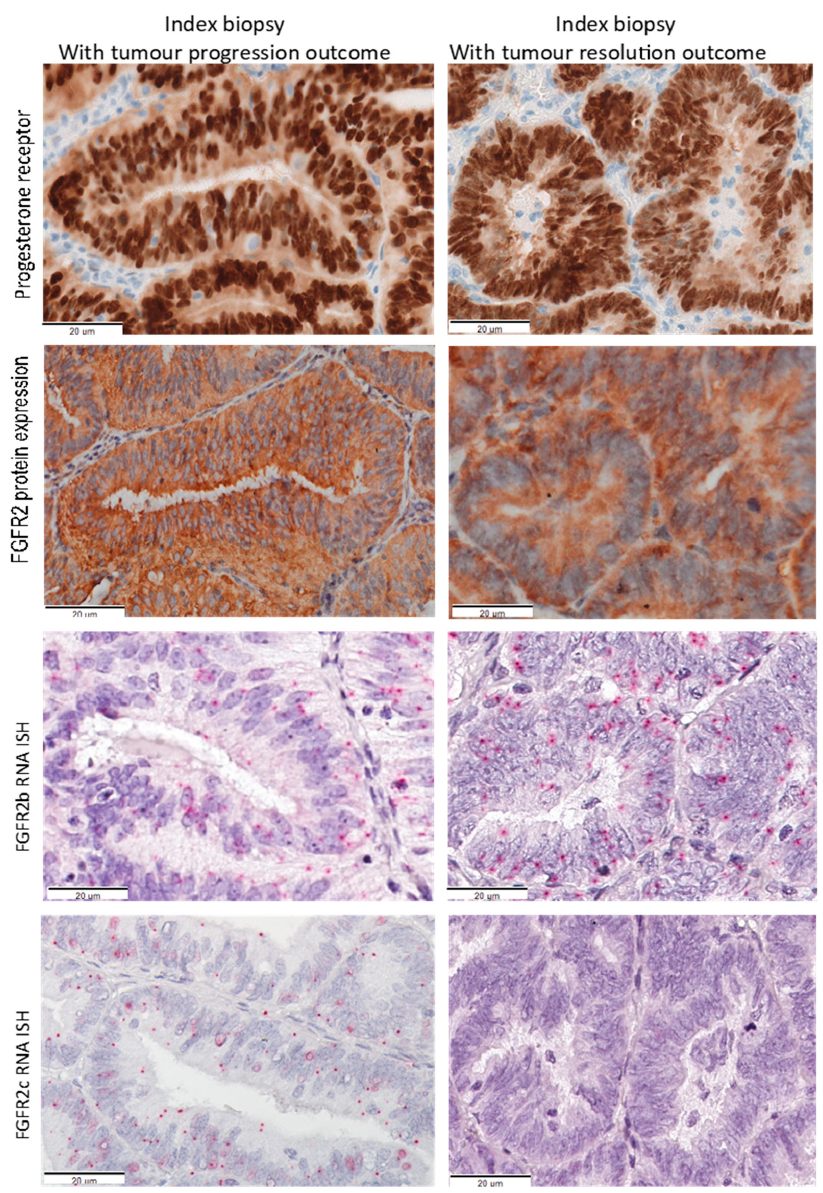
Figure 3. Representative images of PR protein, FGFR2 protein, FGFR2b and FGFR2c mRNA from two different patients with EECs treated with LNG-IUD. Serial sections from the pretreatment diagnostic biopsy of EEC from patient with tumour progression (left panels) and tumour resolution (right panel). Red dots indicate RNA ISH signal product and blue shows nuclear counterstain with haematoxylin. FGFR2c, Fibroblast Growth Factor Receptor 2c isoform; FGFR2b, Fibroblast Growth Factor Receptor 2b isoform; IHC, immunohistochemistry; ISH, In Situ Hybridization; PR, progesterone receptor.